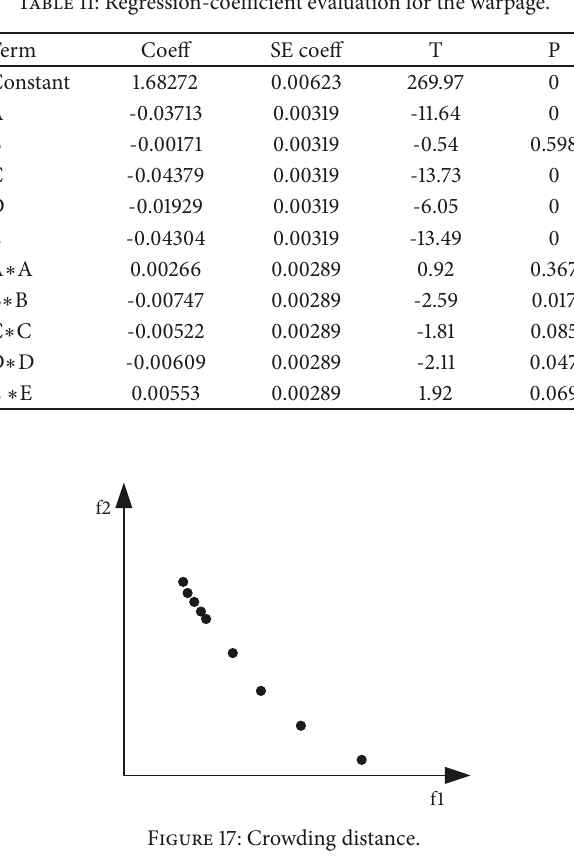
Table 11: Regression-coefficient evaluation for the warpage.